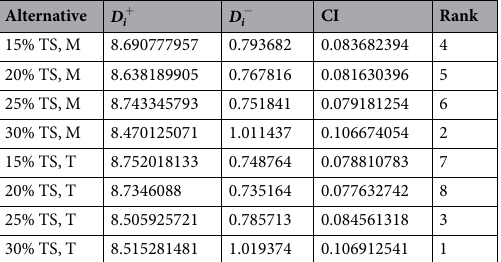
Table 10. The closeness index and the ranking of the